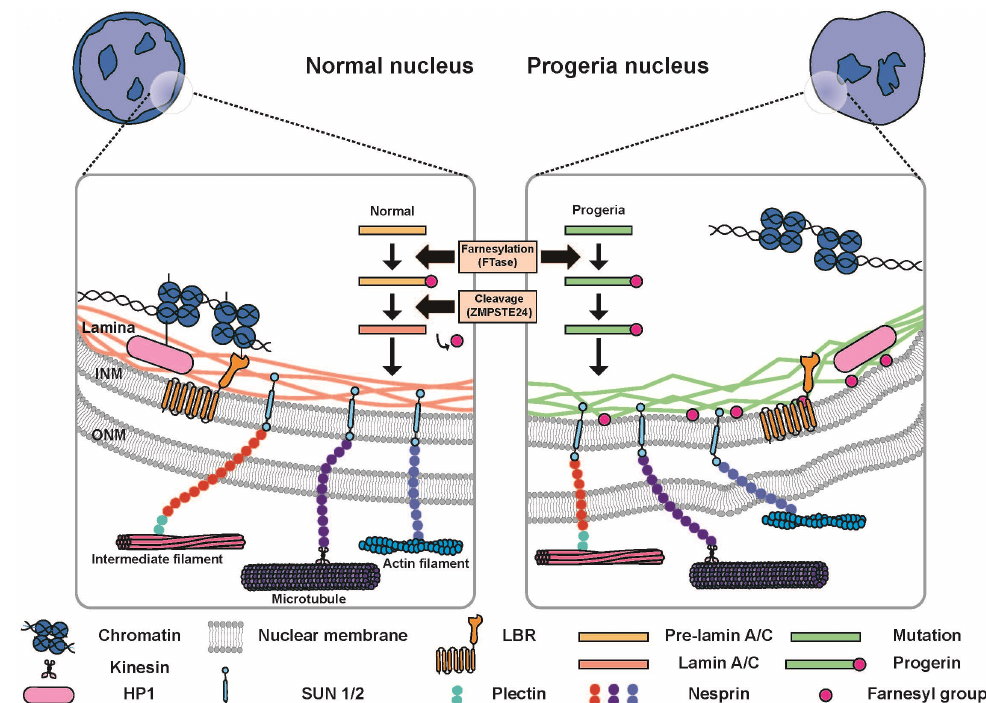
Figure 1. Nuclei of a normal cell and progeria cell. Left: The nuclear lamina is composed of lamin A and C (lamin A/C). Lamin A/C processing consists of multiple steps: (i) The farnesyl group is added to pre-lamin A/C by FTase; and (ii) cleavage by the zinc metalloproteinase Ste24 homologue ( ZMPSTE24 ) finalizes the maturation. Heterochromatin is bound to the nuclear envelope by interactions with HP1 and LBR. Right: The nucleus of the progeria cell does not have heterochromatins bound to the nuclear envelope. Cleavage by the zinc metalloproteinase Ste24 homologue ( ZMPSTE24 ) is not involved in the process of progerin production. Progerin accumulation in the nuclear lamina contributes to the lamina thickening.